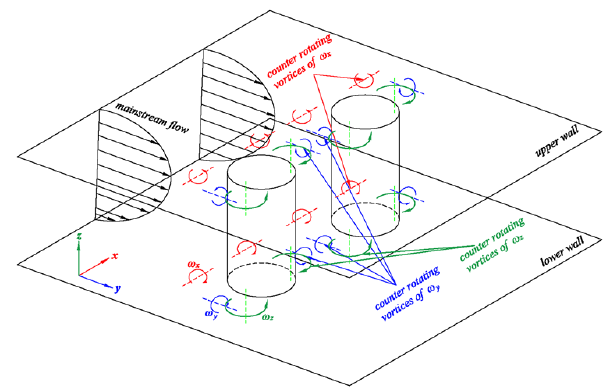
Figure 15. Vorticity magnitude for ( a ) Case 2 and ( b ) Case 8.